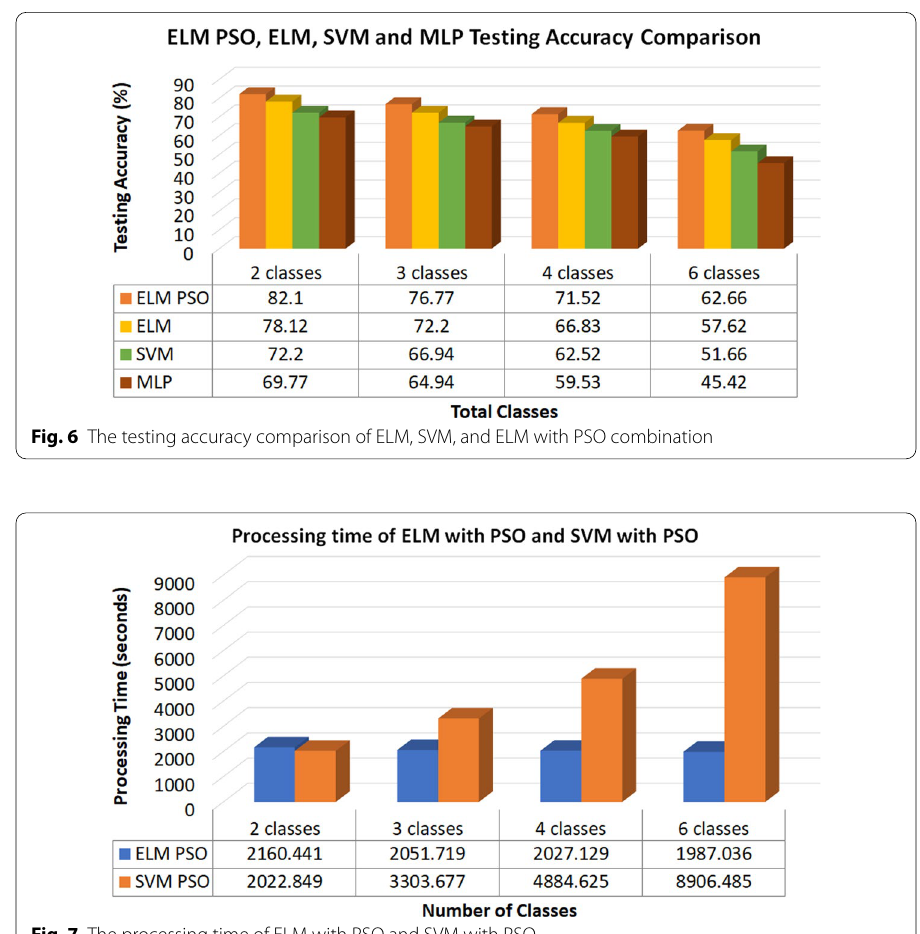
Fig. 7 The processing time of ELM with PSO and SVM with